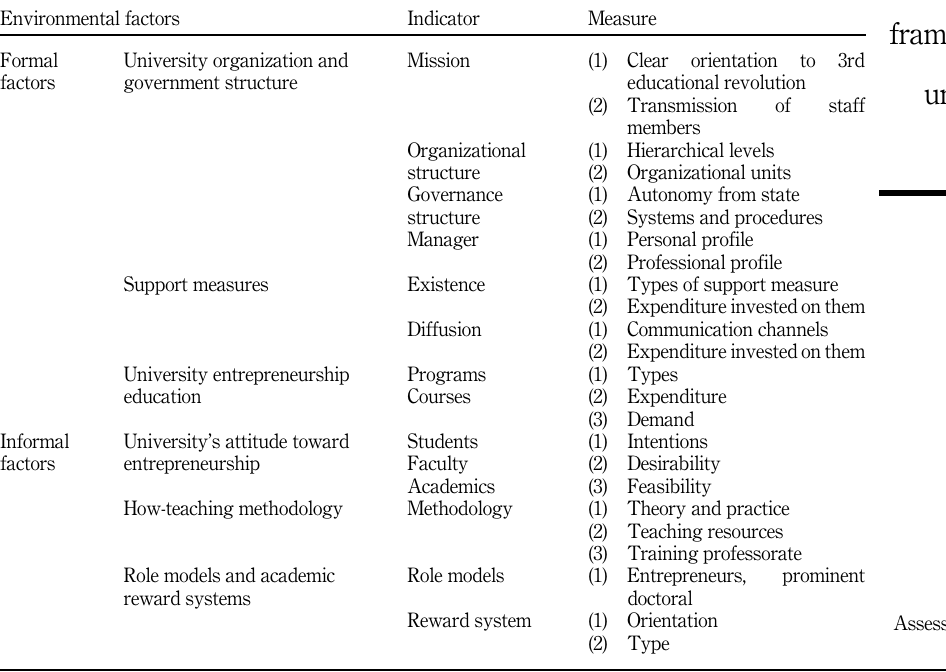
TableII. Assessment model of Guerrero et